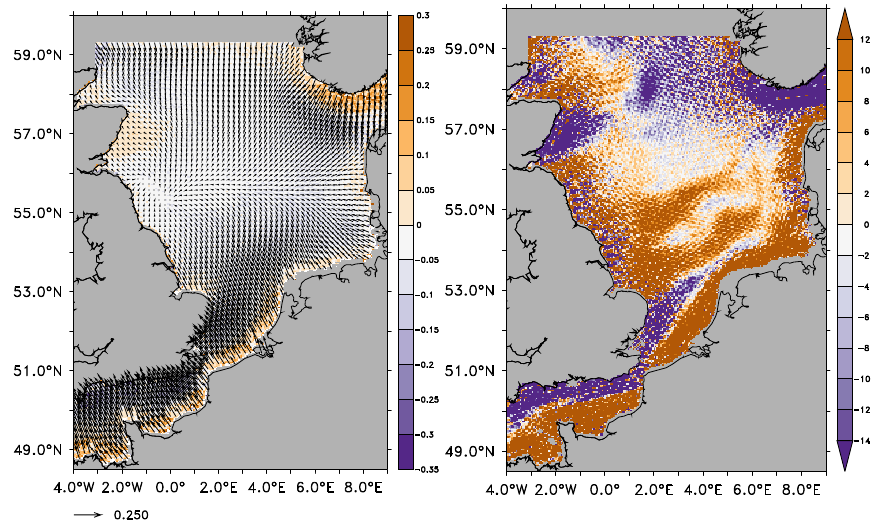
Figure 12. Climatological mean changes in Ekman transport (m 2 /s) (vector) and the corresponding changes in Ekman pumping velocity (10 − 5 m/s) (color) of the RCA4-NEMO RCP8.5 ensemble mean between period P2 and P0 ( left ). The reference vector represents an Ekman transport of 0.25 m 2 /s. Changes in annual mean heat flux between periods P0 and P2 due to Ekman transport divergence (W/m 2 ) ( right